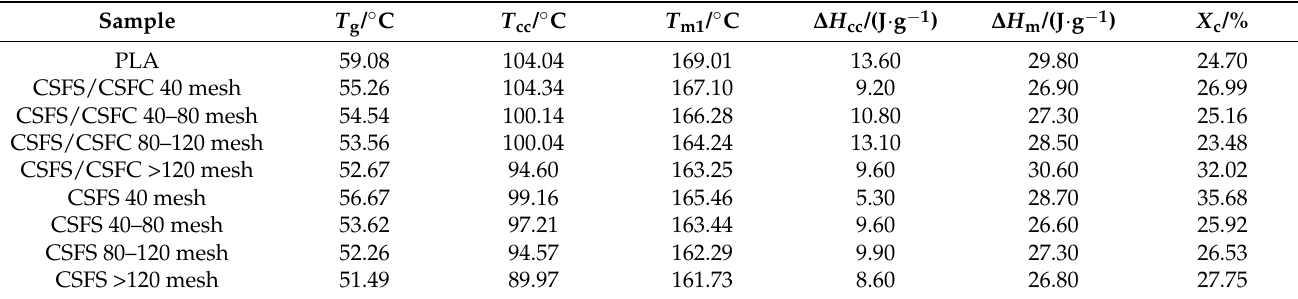
Figure 7. DSC curves of CSFS/CSFC/PLA composites ( a ) and CSFS/PLA composites ( b ) with different particle sizes. Table 1. Characteristic DSC parameters of CSFS/CSFC/PLA composites and CSFS/PLA composites with different particle